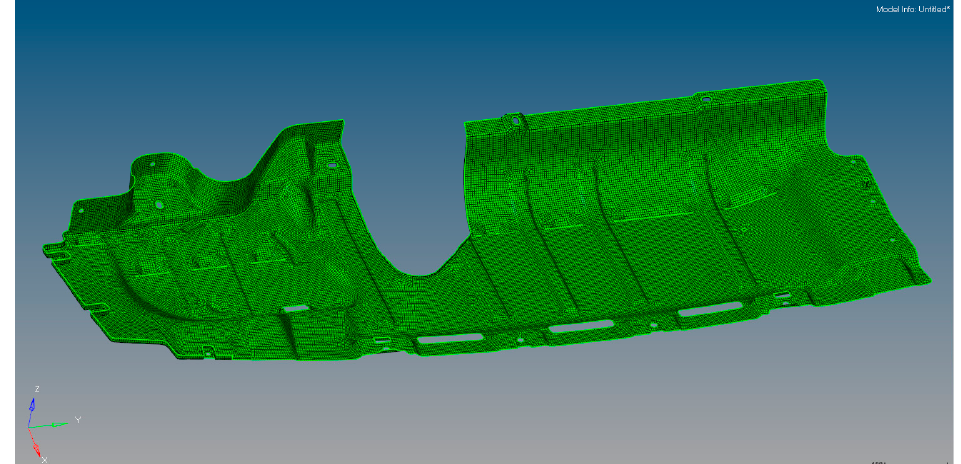
Figure 5. Aerodynamic guard mode with highlight of the adopted mesh.